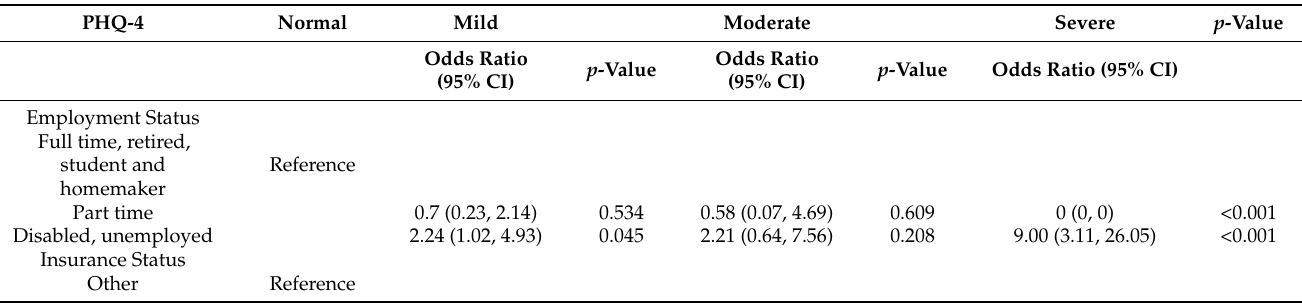
Table 3. Multivariate model. PHQ-4 score change and 95th percentile confidence interval for adjusted associations between socioeconomic status, race, and PHQ-4 score. All values were adjusted for age, sex, and